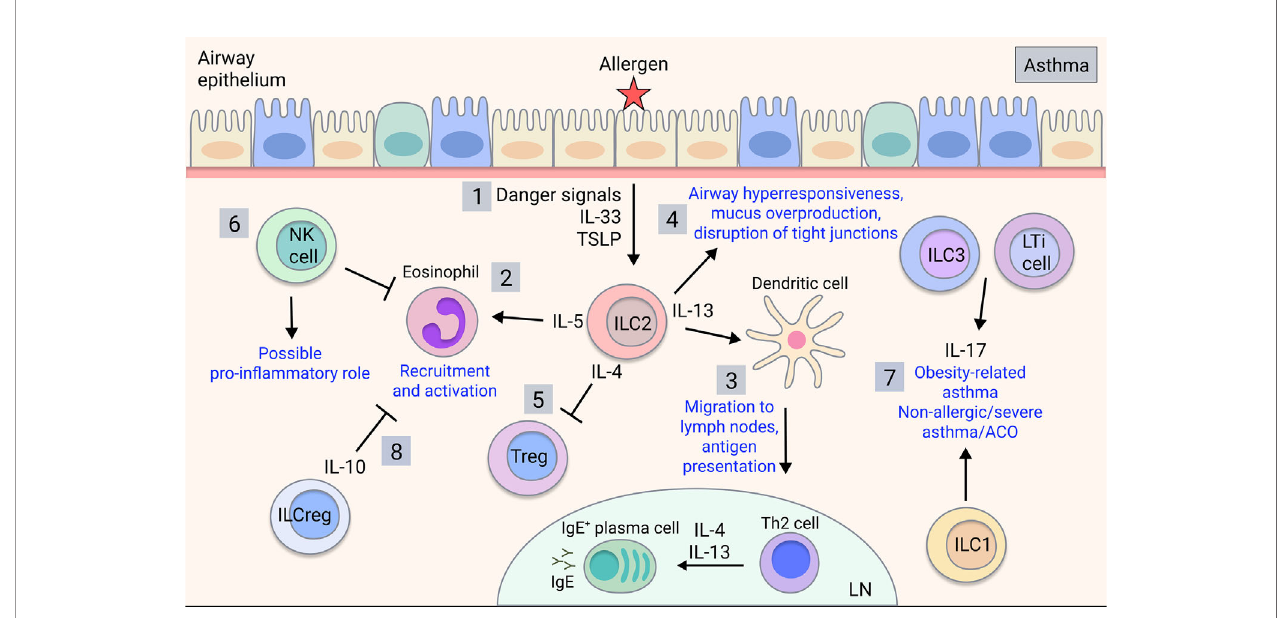
FIGURE 2 | ILC involvement in asthma. Upon allergen detection by airway epithelium, 1) ILC2s are activated by signals released by the airway epithelial cells and other activated immune cells, producing type 2 cytokines such as IL-4, IL-5, and IL-13 in allergic asthma. 2) IL-5 is key for eosinophil recruitment and activation in the lung (77) and 3) IL-13 mediates dendritic cell migration to the lymph nodes, promoting T cell differentiation into effector Th2 cells, which mediate B cell class- switching and IgE production (78). 4) ILC2-derived IL-13 also acts on the airway epithelium to induce airway hyperresponsiveness, mucus overproduction and disruption of barrier integrity (43, 79, 80). 5) ILC2-derived IL-4 may potentially inhibit T reg production in asthma (81). 6) NK cells play an ambiguous role in asthma with both disease-driving and disease-modulatory activity shown. 7) ILC3s/LTi cells and possibly ILC1s contribute to obesity-related asthma and potentially non- allergic, severe asthma or ACO through production of IL-17 (82). 8) ILC regs may regulate asthma by inhibiting eosinophil recruitment through IL-10